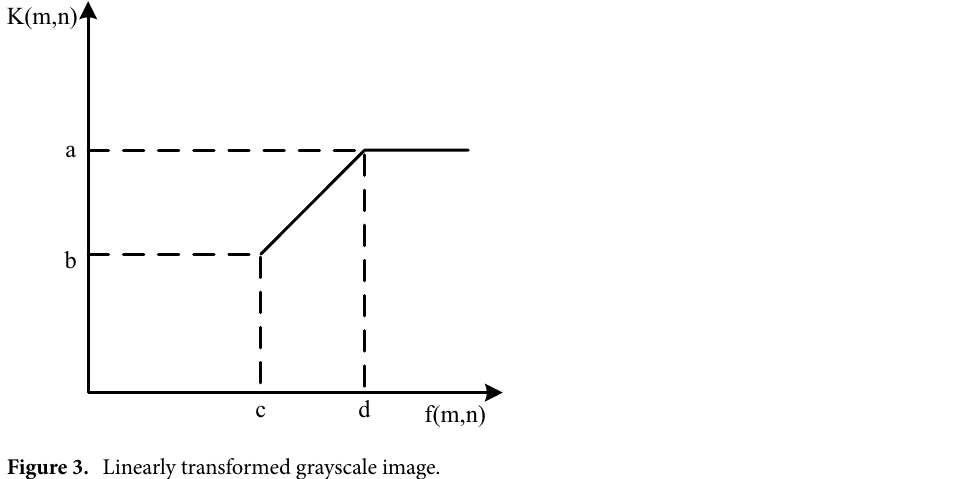
Figure 3. Linearly transformed grayscale